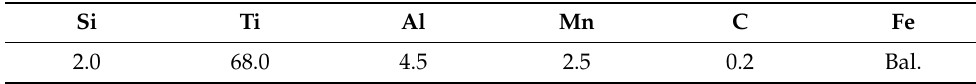
Table 3. FeTi70 modifier composition